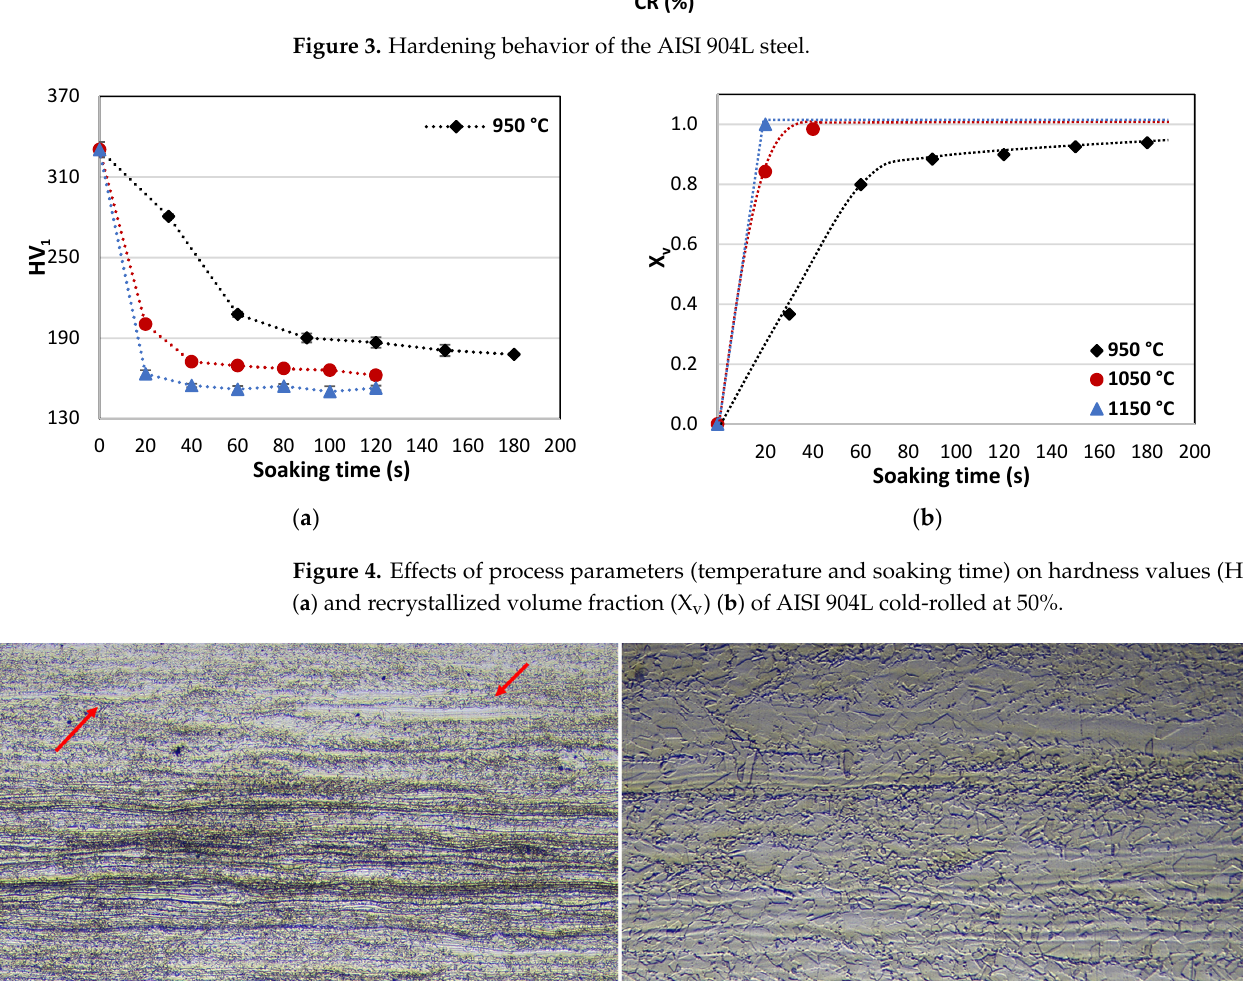
Figure 3. Hardening behavior of the AISI 904L steel.